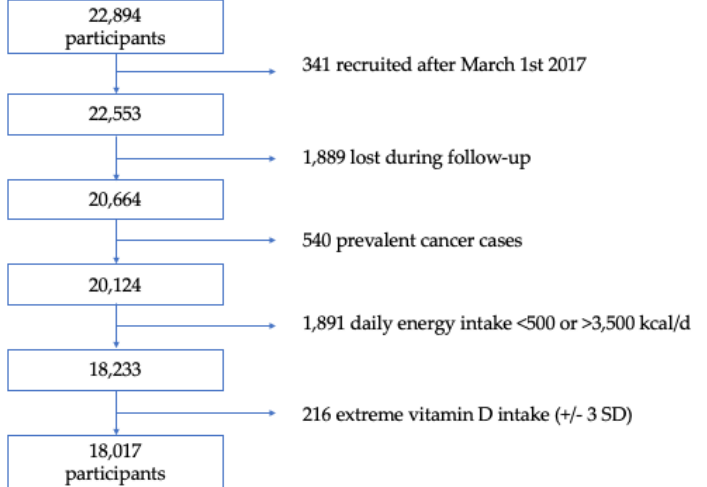
Figure 1. Flowchart of participants in the SUN Project, 1999–2019. Kcal/d: kilocalorie per day. SD: standard deviation.